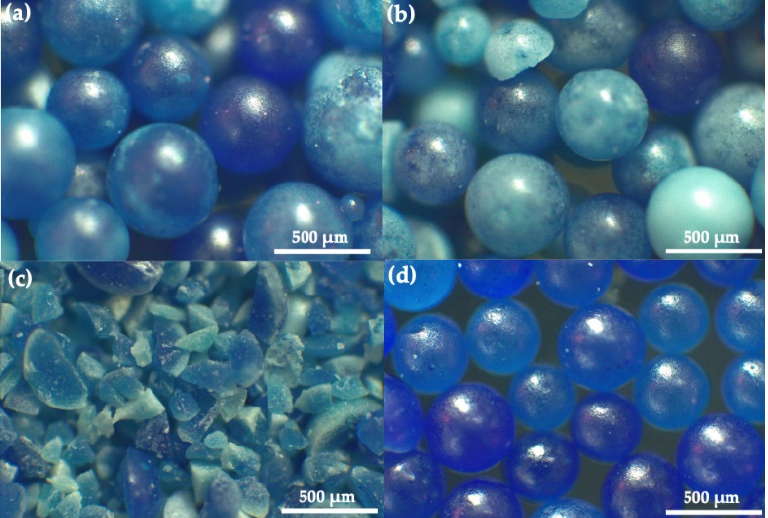
Figure 8. Optical micrographs of the HDPE MPs after visible-light photocatalytic degradation for 50 h by C,N-TiO 2 in the presence of ( a ) tert-Butanol, ( b ) isopropyl alcohol ( c ) Tiron, and ( d ) copper nitrate scavengers.